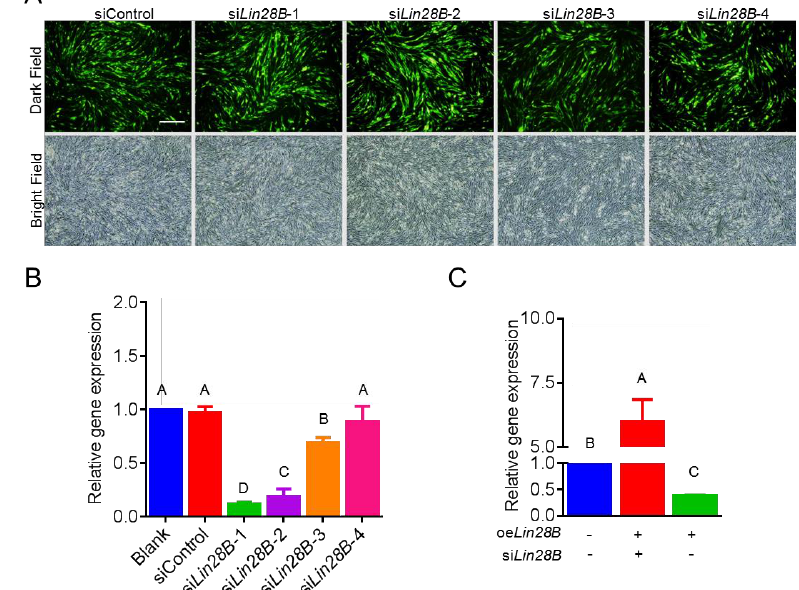
Figure 2. Activity detection of overexpression and interference vector of Lin28B. ( A ) Lin28B inter- ference vector transfected into DF-1 cells, non-transfected cells were blank control, Scale bar: 50 µ m. ( B ) qRT-PCR was used to detect the relative Lin28B gene expression following siLin28B 1-4 vector transfection. ( C ) Activity detection of Lin28B overexpression and interference vector by the rescue experiment. Different uppercase letters represent highly significant, and the same letters represent no significant.